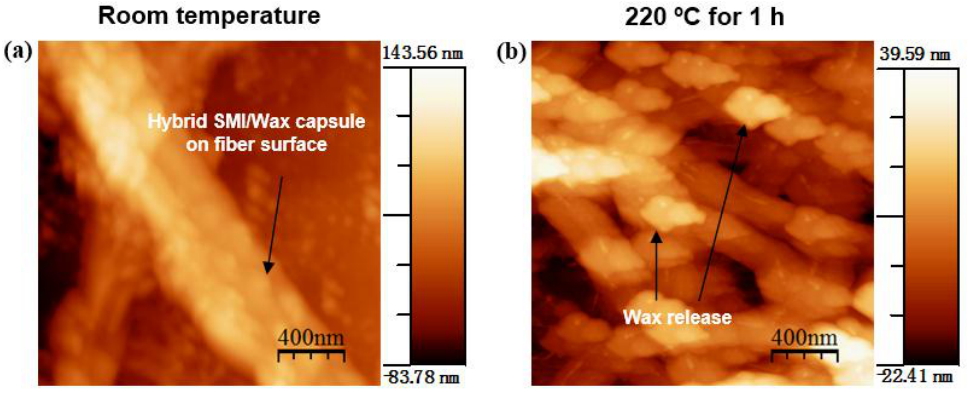
Figure 7. Atomic force microscopy (AFM) morphology of modified MFC films ( a ) non-cured; and ( b ) cured at maximum temperatures of 220